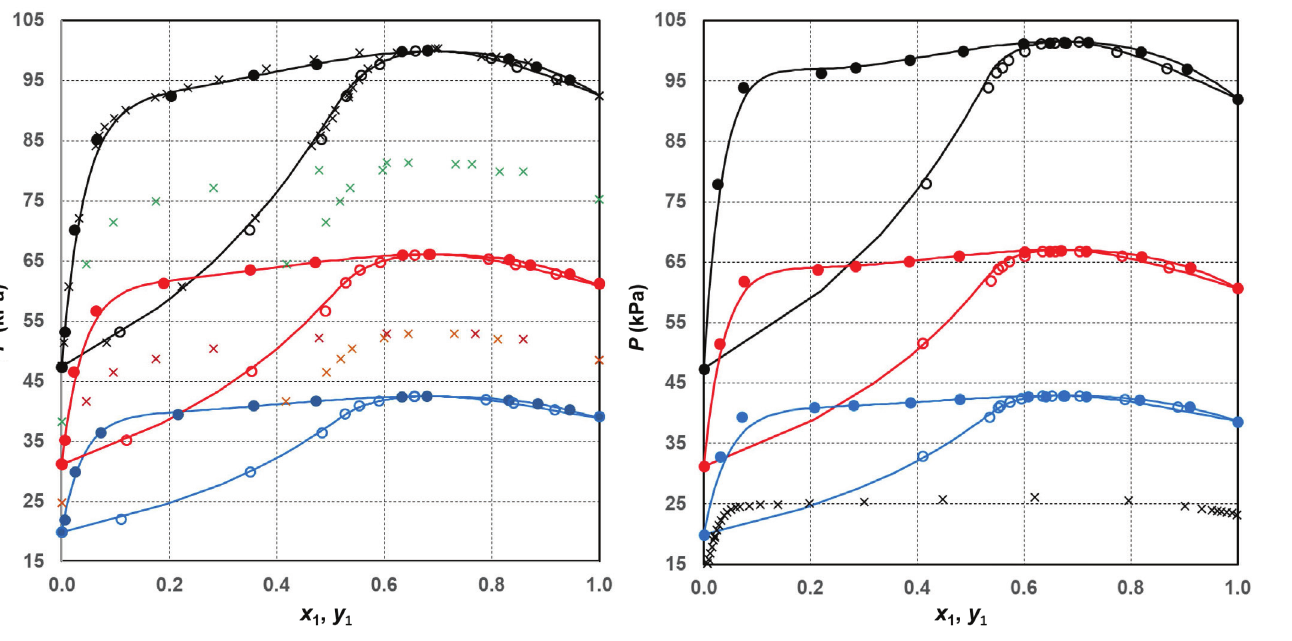
Fig. 1 – Vapor-liquid equilibrium in the 2-propanol + water (2) system. Experimental points: (  ,  ) 333.15 K, (  ,  ) 343.15 K, (  ,  ) 353.15 K, × 353.15 K (ref 5 ), × 348.1 K (ref 6 ), × 338.1 K (ref 6 ). Lines represent NRTL correlation.